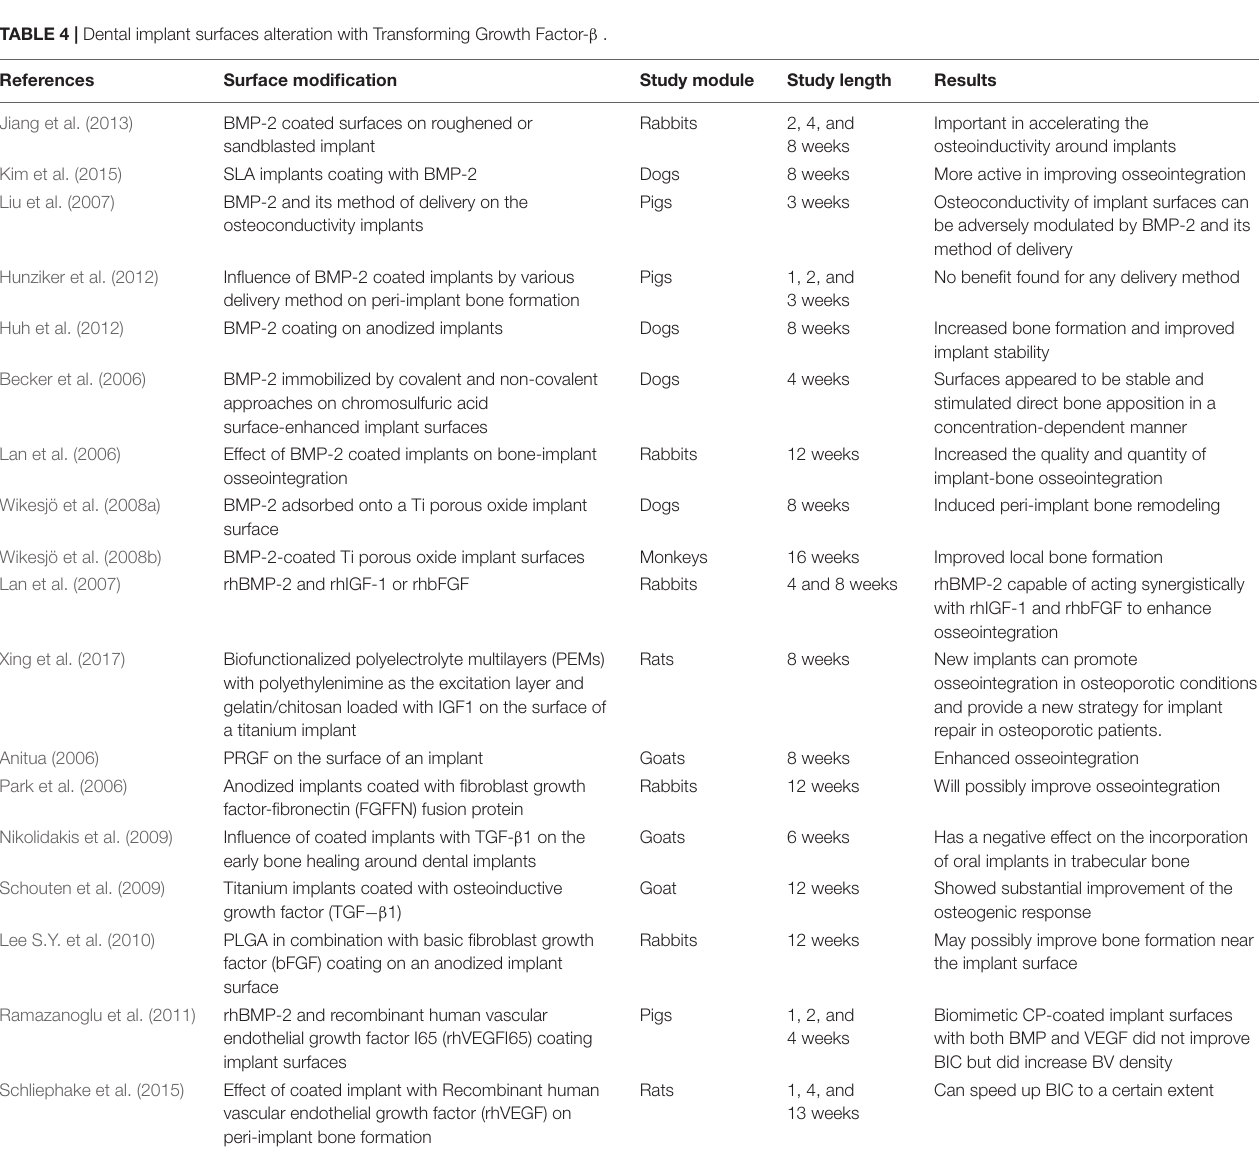
TABLE 4 | Dental implant surfaces alteration with Transforming Growth Factor- β